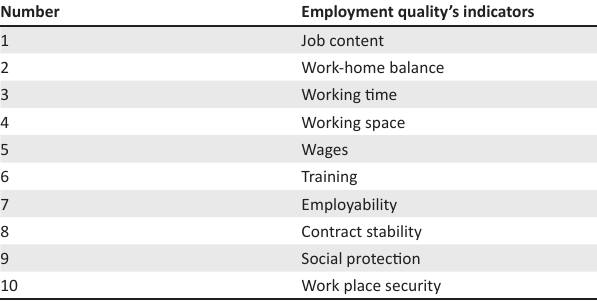
TABLE 1: Synthesis of the employment quality indicators.